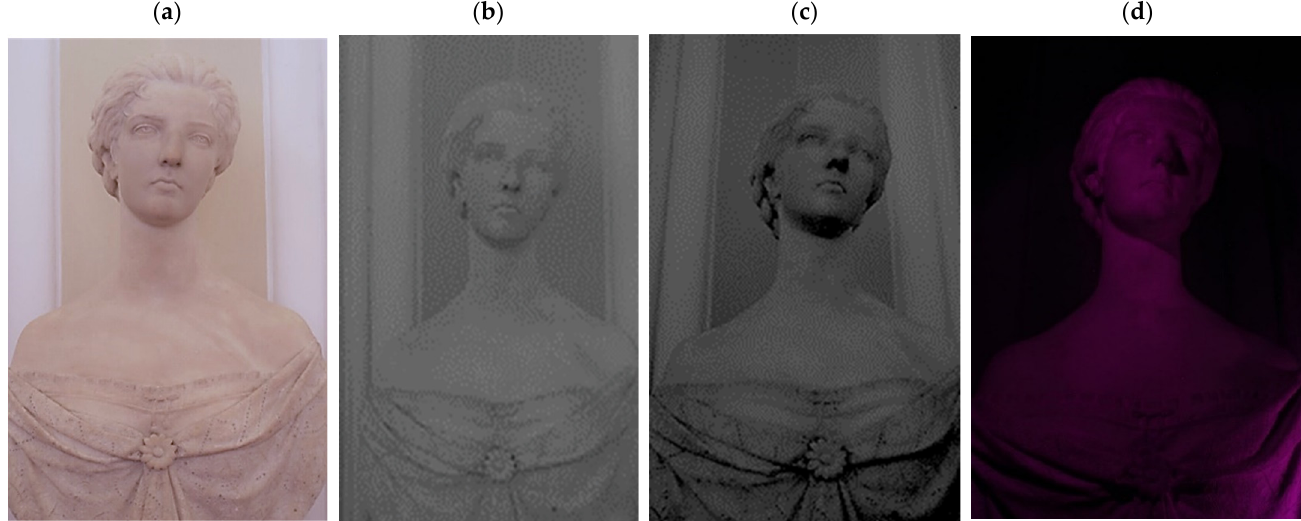
Figure 5. IR and UV reflectography acquisitions compared to the picture under visible light. ( a ) Visible light; ( b ) IR reflectography (750 nm); ( c ) IR reflectography (850 nm); ( d ) UV reflectography. Colorimetric measurements were acquired in points 1 to 8. As points 1 and 2 were